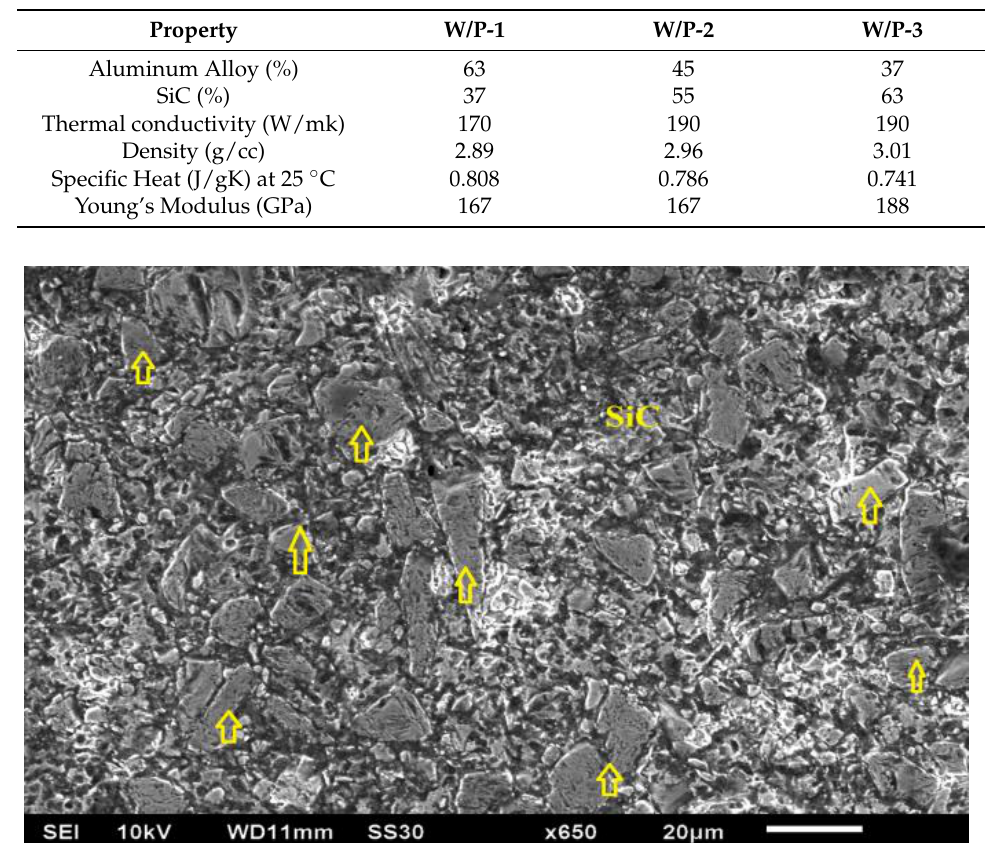
Figure 1. SEM (Make: JSM-6610LV Joel, Tokyo, Japan) of un-machined surface of Al-SiC workpiece at X650 (SiC particulates are highlighted with yellow color arrows).